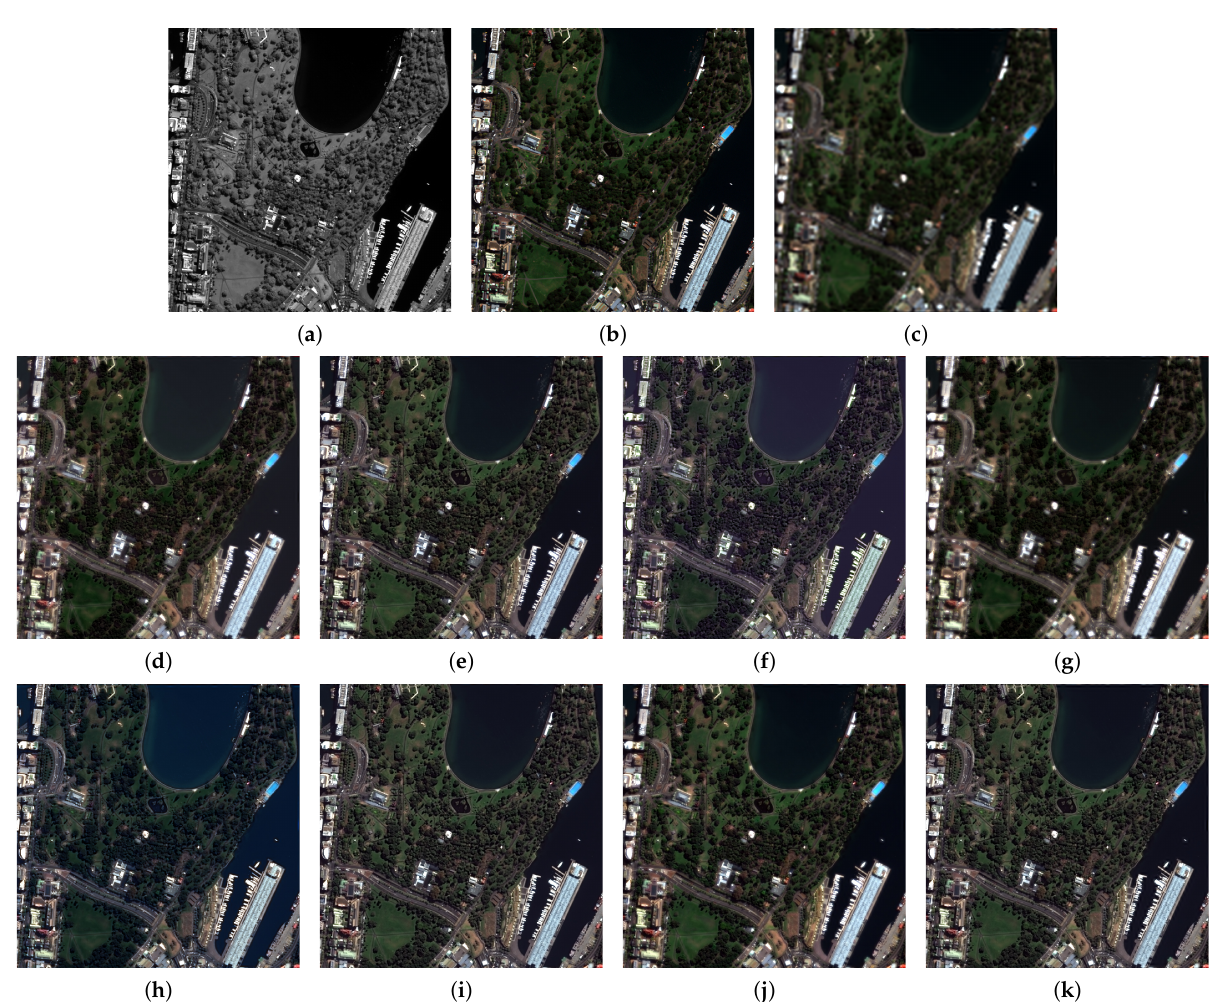
Figure 6. Fusion results at reduced resolution (512 512), in natural colors, for the WorldView-2 Sydney dataset: ( a ) Pan; ( b ) × reference MS (REF); ( c ) expanded MS (EXP); ( d ) GS; ( e ) GSA; ( f ) GIHS; ( g ) PCA; ( h ) BT; ( i ) MTF-GLP; ( j ) BDSD; ( k )